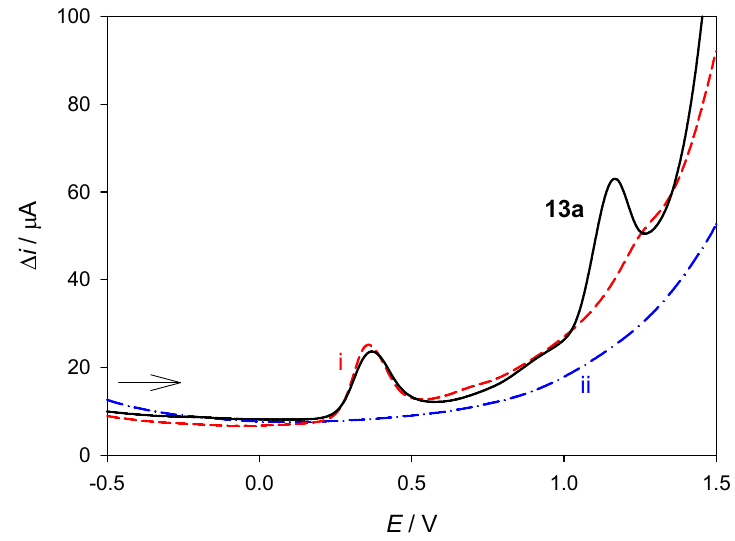
Figure 3. Square-wave voltammograms for the oxidation of ethynyl ferrocene (i), 6-chloropurine (ii) and 13a in 0.5 mol/L NaClO 4 at pH 9. Conditions: c (i) = c (ii) = c ( 13a ) = 0.1 mmol/L, E sw = 50 mV, E s = 2 mV, f = 100 Hz. Arrow indicates the scan direction.